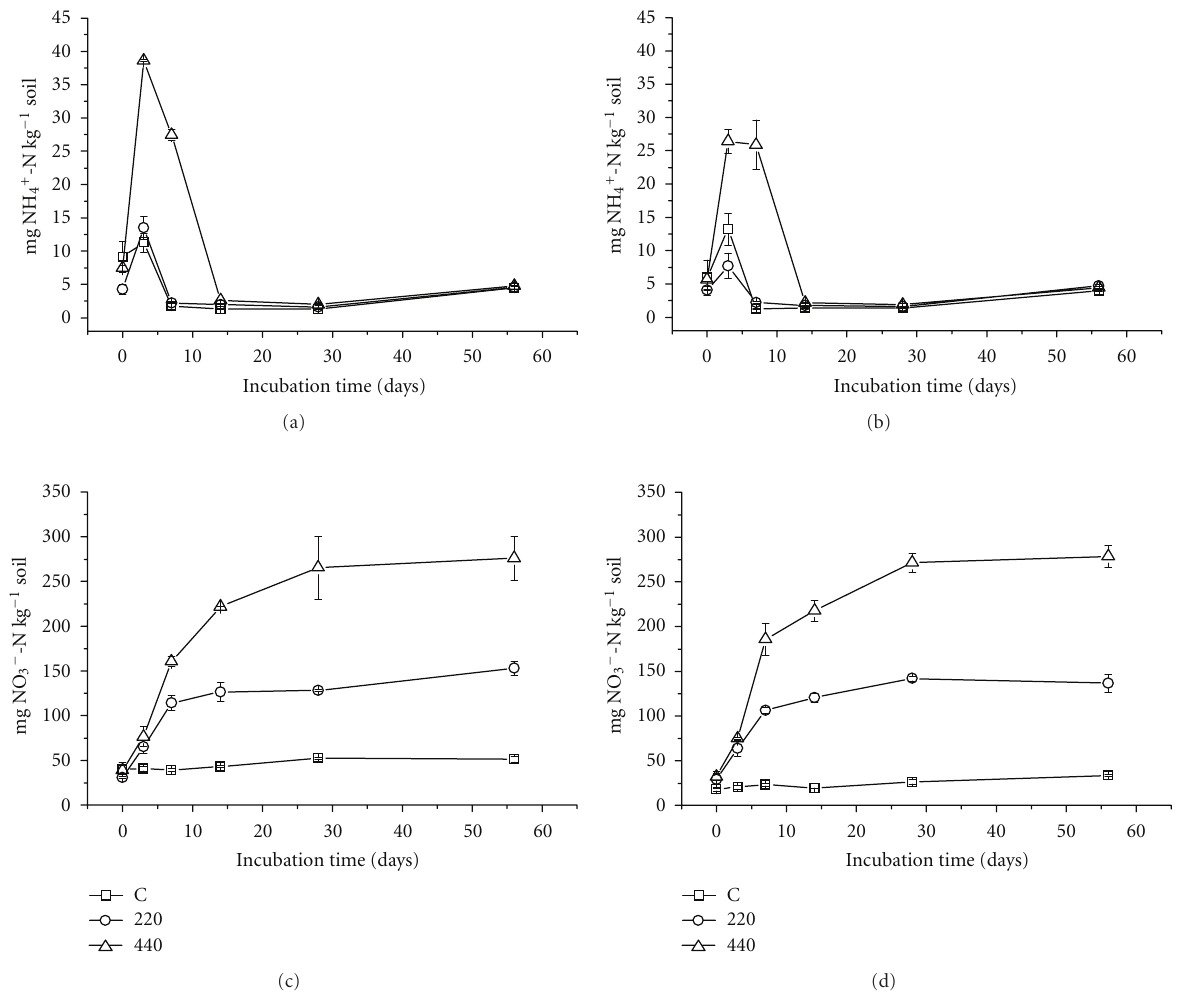
Figure 1: Concentrations of K 2 SO 4 extractable NH 4 + -N in soil M (a) and soil P (b) and K 2 SO 4 extractable NO 3 − -N in soil M (c) and soil P (d) at di ff erent sampling times. C: controls; 220: TLP addition rate at 220kg Nha − 1 ; 440: TLP addition rate at 440 kg Nha − 1 ; bars represent standard deviation ( n =